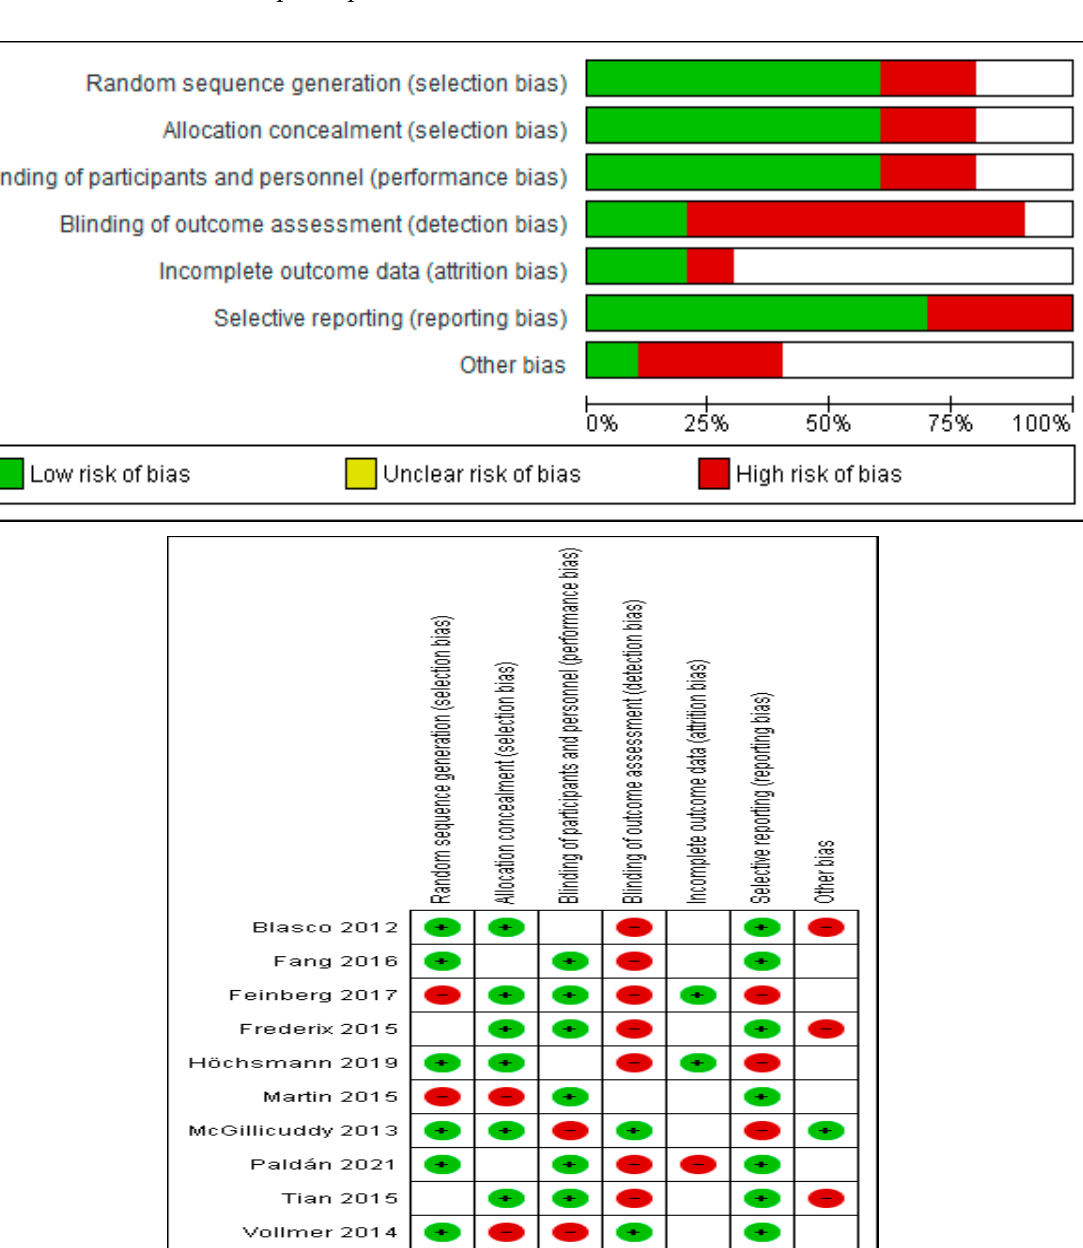
Figure 2. Risk of bias graph; (Red Circles indicating High Risk of Bias, while Green Circles Indicate Low Risk of bias).